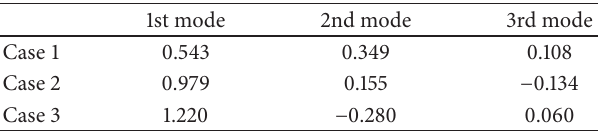
Figure 2: Comparison of the magnitude of frequency response functions (accelerances) for the first floor acceleration.